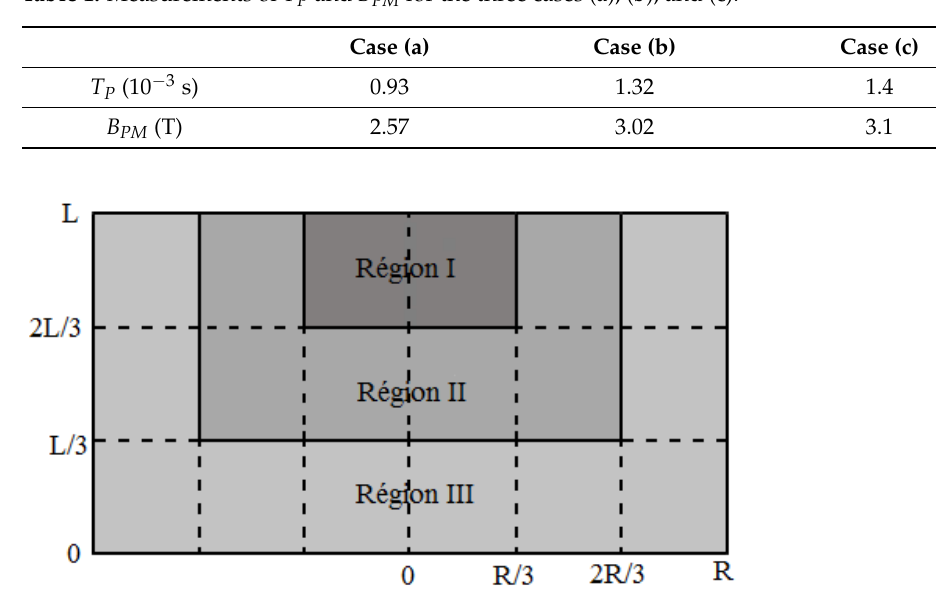
Figure 13. Model of HTS bulk considering homogeneity.